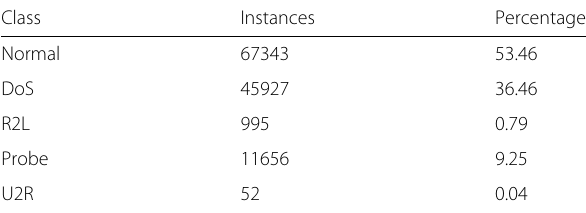
Table 3 Number of instances in NSL-KDD